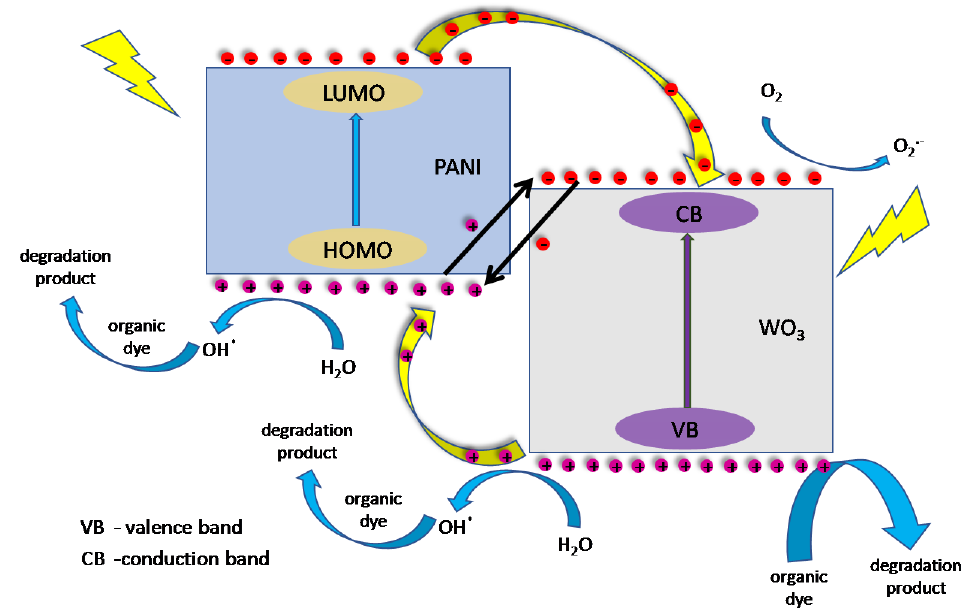
Figure 11. Schematic mechanism of a dye photodecomposition by the FTO / PANI / WO 3